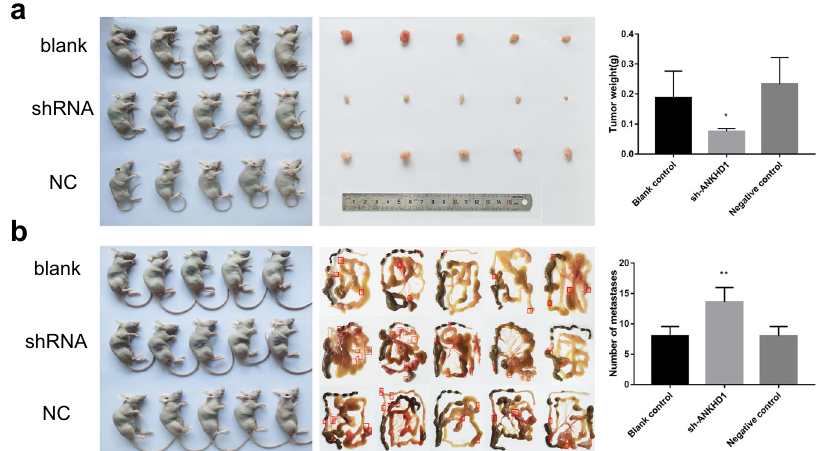
Fig. 7 Loss of function experiment in vivo. The nude mice xenograft experiment in subcutaneous ( a ) and the peritoneal metastasis experiment ( b ). * p < 0.05; ** p < 0.01. The data shown are the mean ± SD.